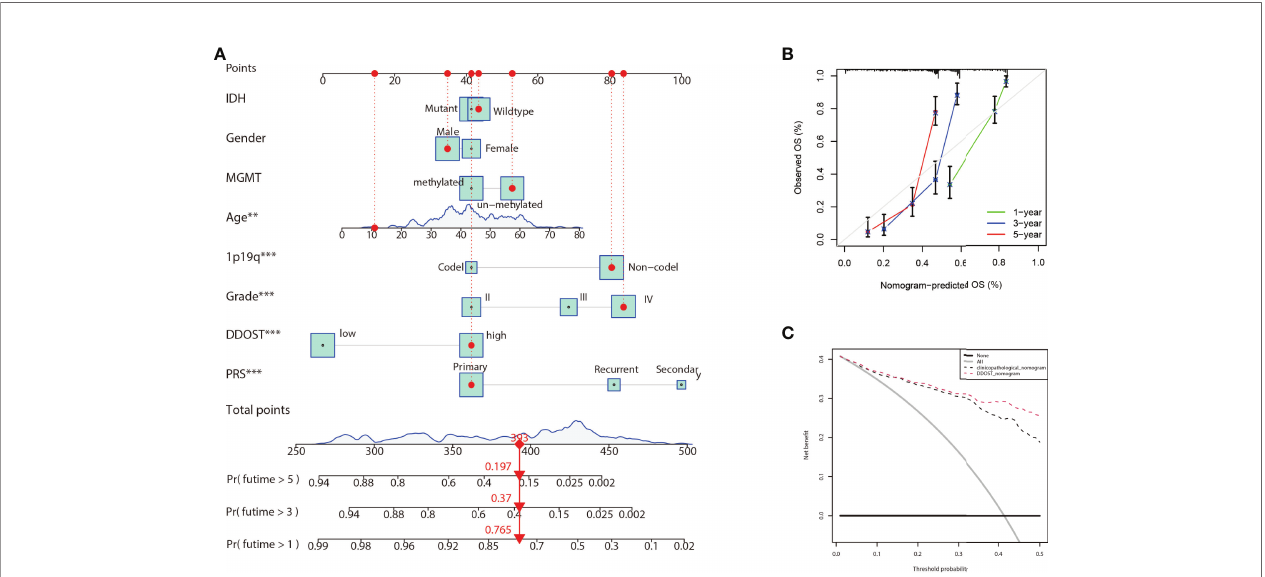
FIGURE 11 | Nomogram for the prediction of prognostic probabilities in the CGGA dataset. (A) The nomogram for the prediction of OS was developed using the CGGA dataset. (B) The calibration plots for predicting 1-, 3-, and 5-year survival. (C) Decision curve analysis for the DDOST nomogram and the clinicopathological nomogram to estimate the